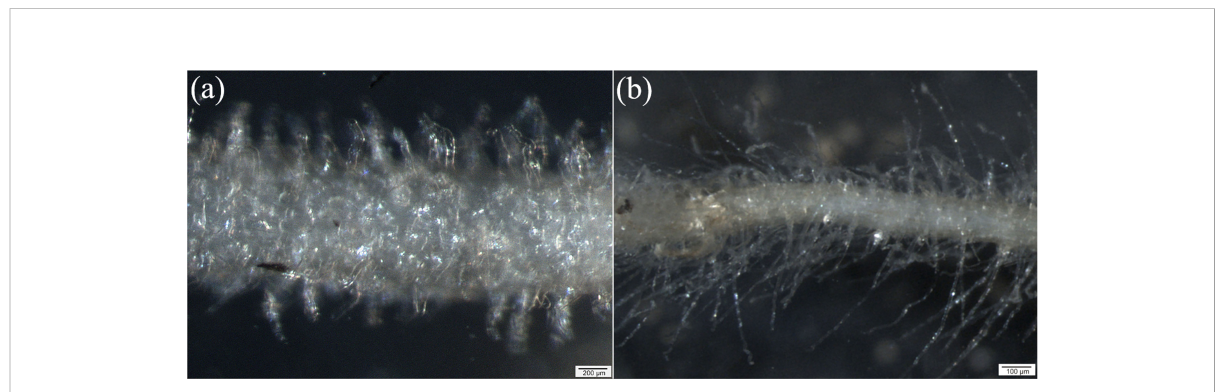
FIGURE 2 Stereomicroscope images of root hair zone of European beech (A) and Norway spruce (B) .